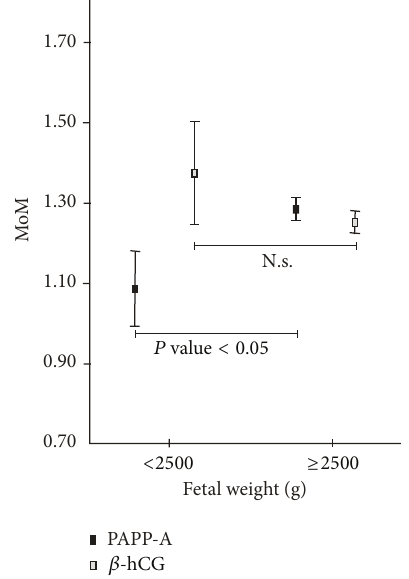
Figure 3: Variation of PAPP-A and 𝛽 -hCG according to fetal weight at delivery